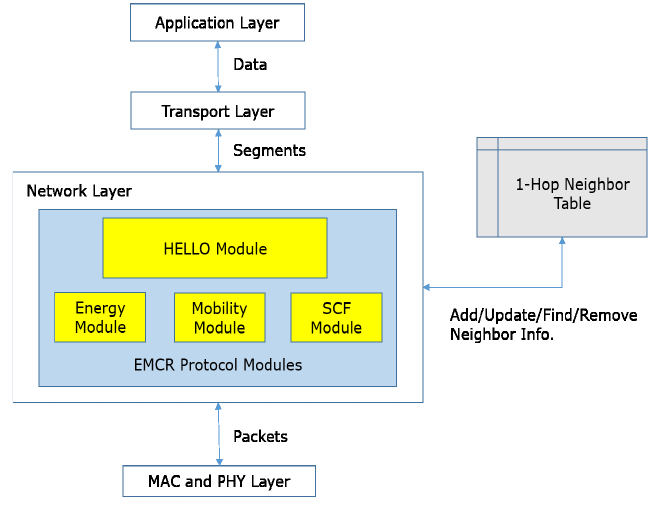
Figure 3. EMCR system